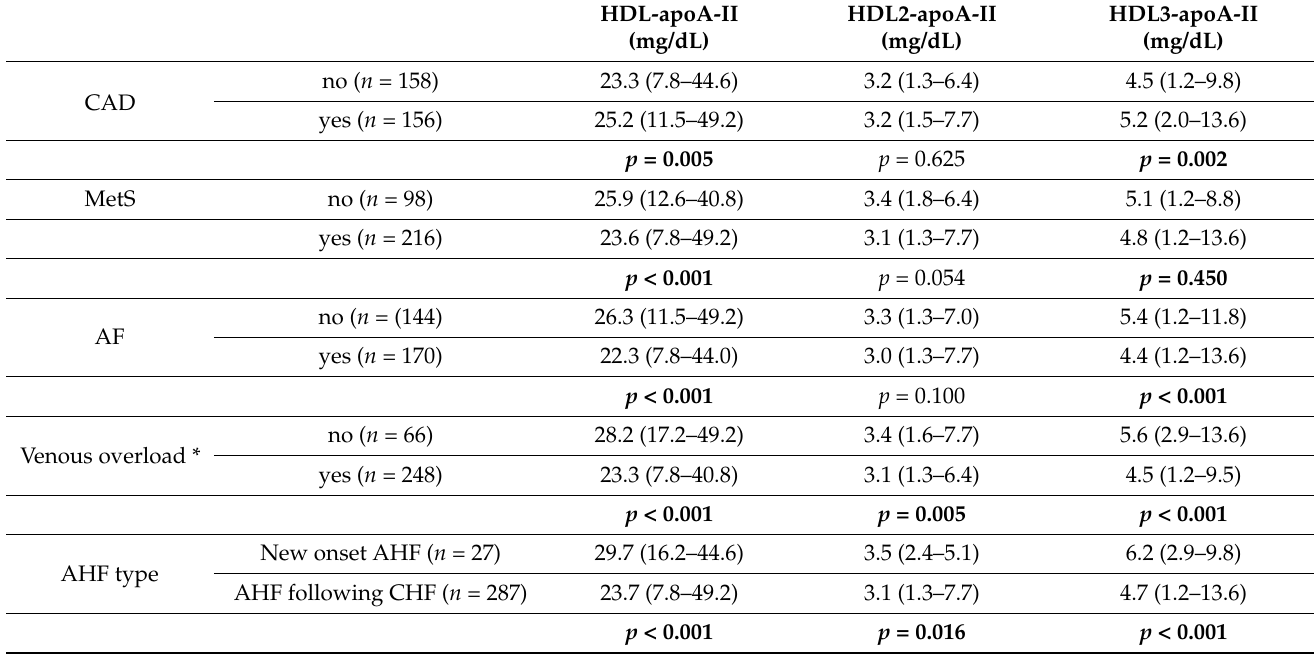
Table 4. Serum levels of HDL parameters in various groups of AHF